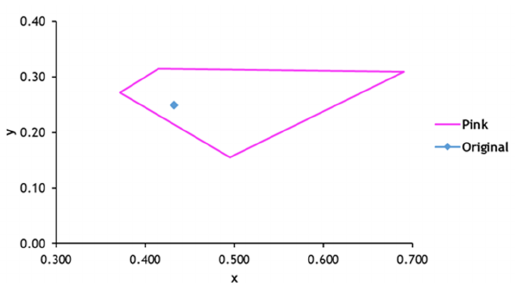
Figure 6. Chromaticity coordinates obtained for industrial coated sample with 2% MG 521 pigment.